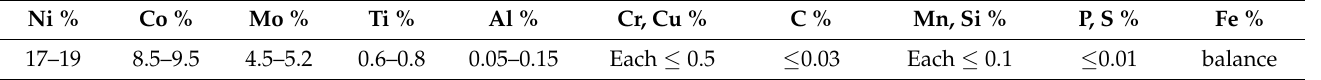
Table 1. Material